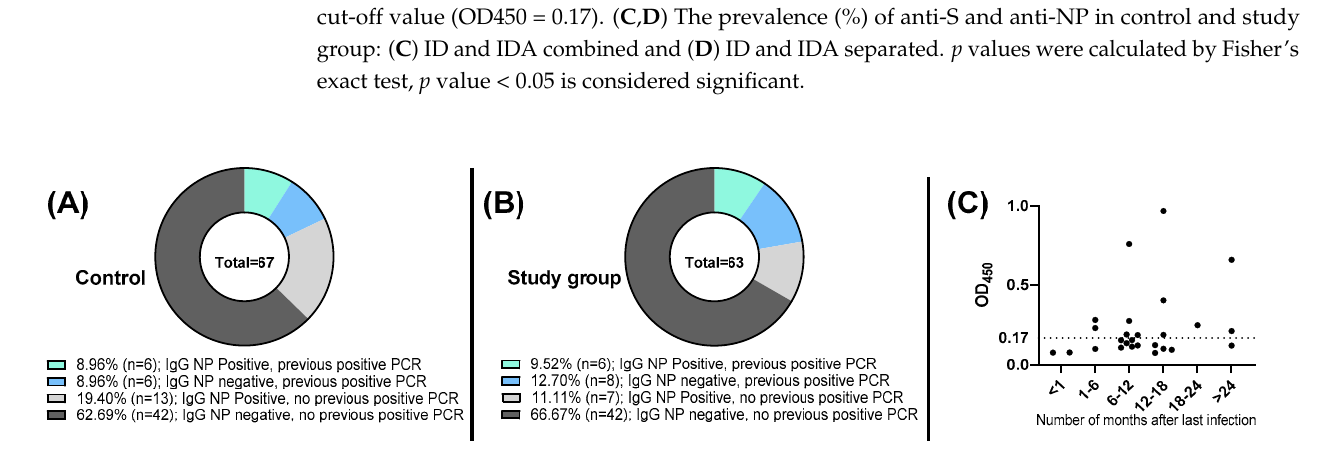
Figure 3. Analysis of anti-SARS-CoV-2 NP IgG in control group (normal hemoglobin and ferritin) and study group (ID, IDA). ( A ) Prevalence of IgG NP among control group. ( B ) Prevalence of IgG NP among study group. ( C ) OD450 readings of NP-based ELISA across different time periods among participants who had reported previous positive COVID-19 PCR result in the entire population. Dashed black line represents NP-based ELISA cut-off (OD450 = 0.17).